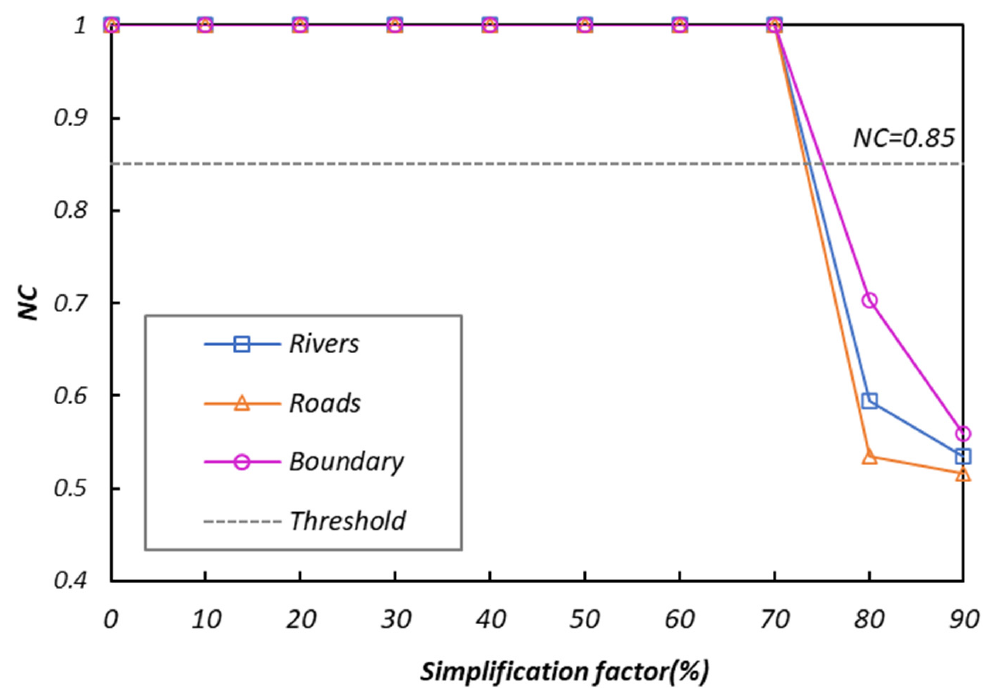
Figure 9. The results of simplification